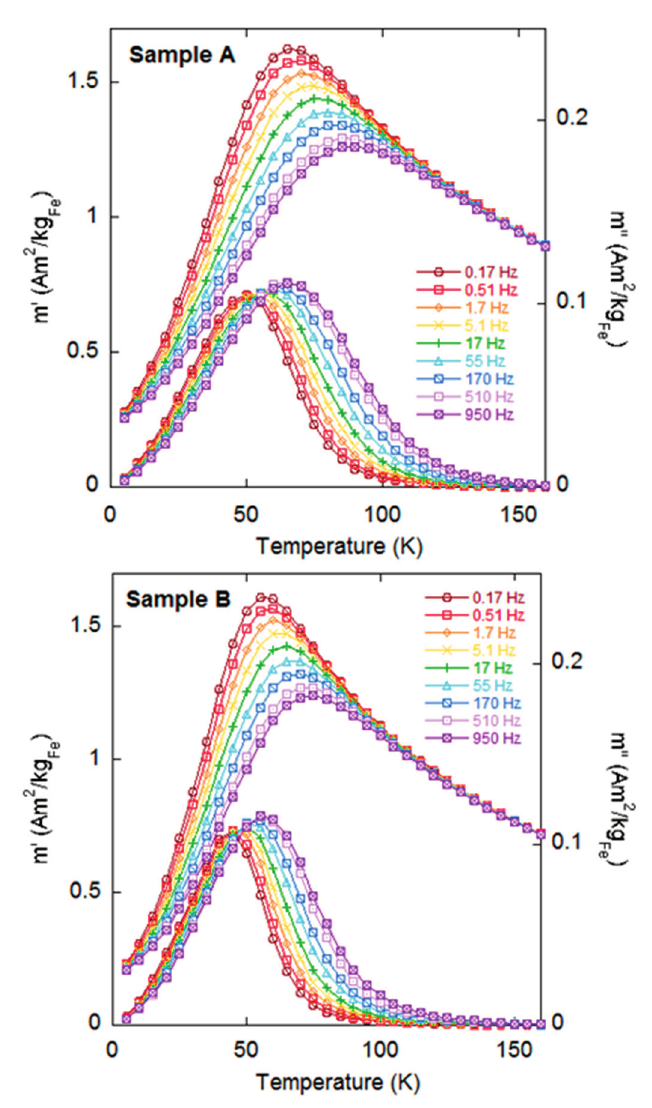
Figure 7. AC magnetization versus temperature for samples A and B. The different curves correspond to different frequencies of the AC magnetic field. The AC magnetic field amplitude is 320